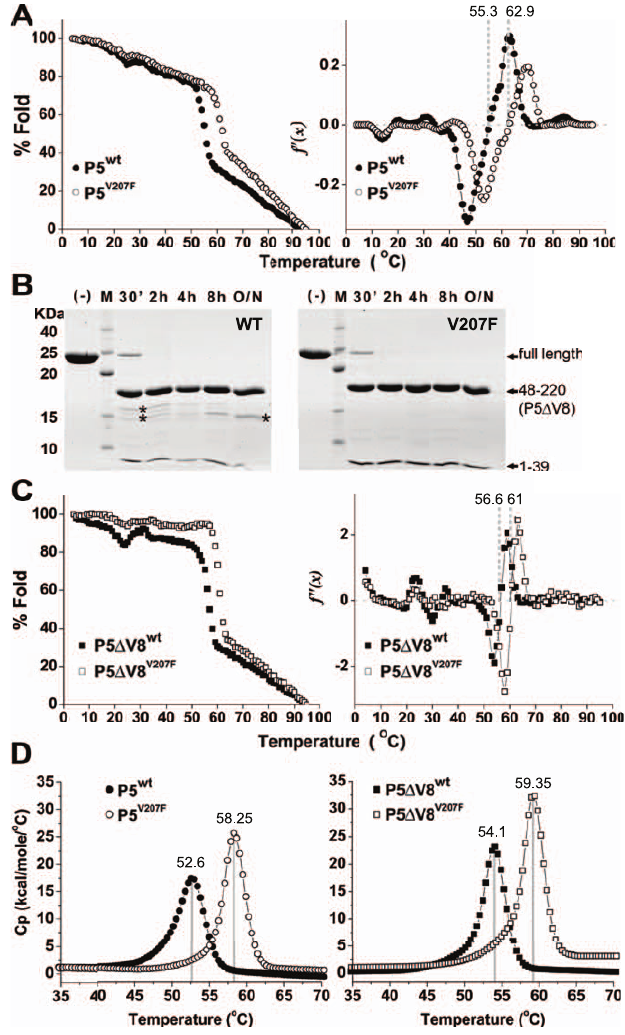
Figure 2. Thermal and proteolytic stabilities of P5 wt and P5 V207F . A) Thermal melting of P5 wt and P5 V207F measured by circular dichroism (CD) spectrometry at 220 nm. P5 wt and P5 V207F began to unfold cooperatively at 50–55 u C (left panel). Melting temperatures were calculated from the second derivative of the CD melting curves (right panel). The V207F mutation increases the melting temperature of P5 by 7.6 u C. B) Limited proteolysis of P5 D V8 wt and P5 D V8 V207F with V8 (Glu-C) protease monitored by SDS-PAGE. Some minor proteolytic products (marked by asterisks) are visible in P5 D V8 wt . C) Thermal melting curves of P5 D V8 wt and P5 D V8 V207F , with melting temperatures calculated as in (A). D) Differential Scanning Calorimetry (DSC) of P5 and P5 D V8 proteins. Peaks indicate a 6 u C difference between the melting points of wildtype and mutant P5.